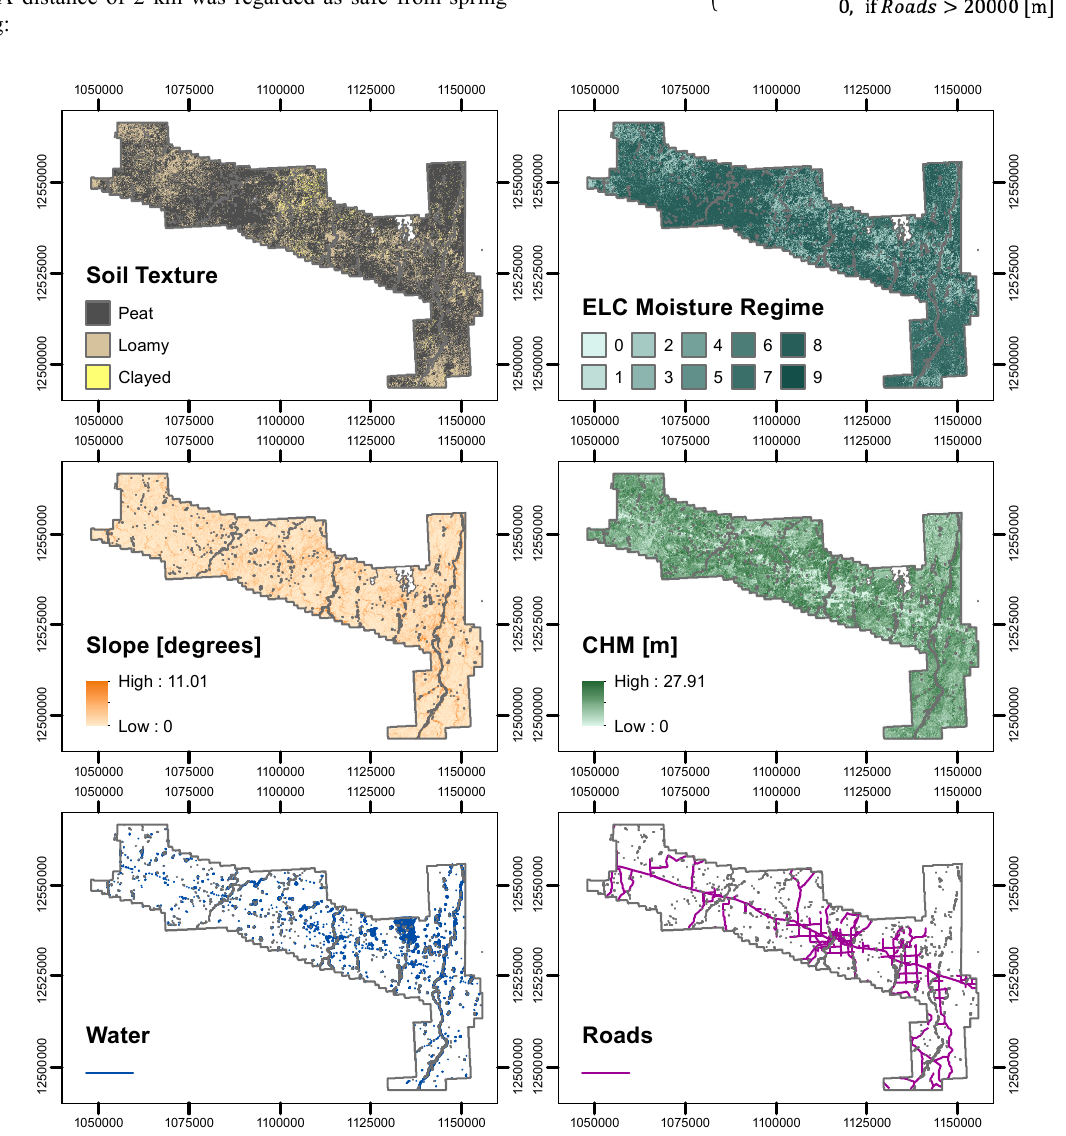
Figure 2. Attribute layers considered for agriculture suitability